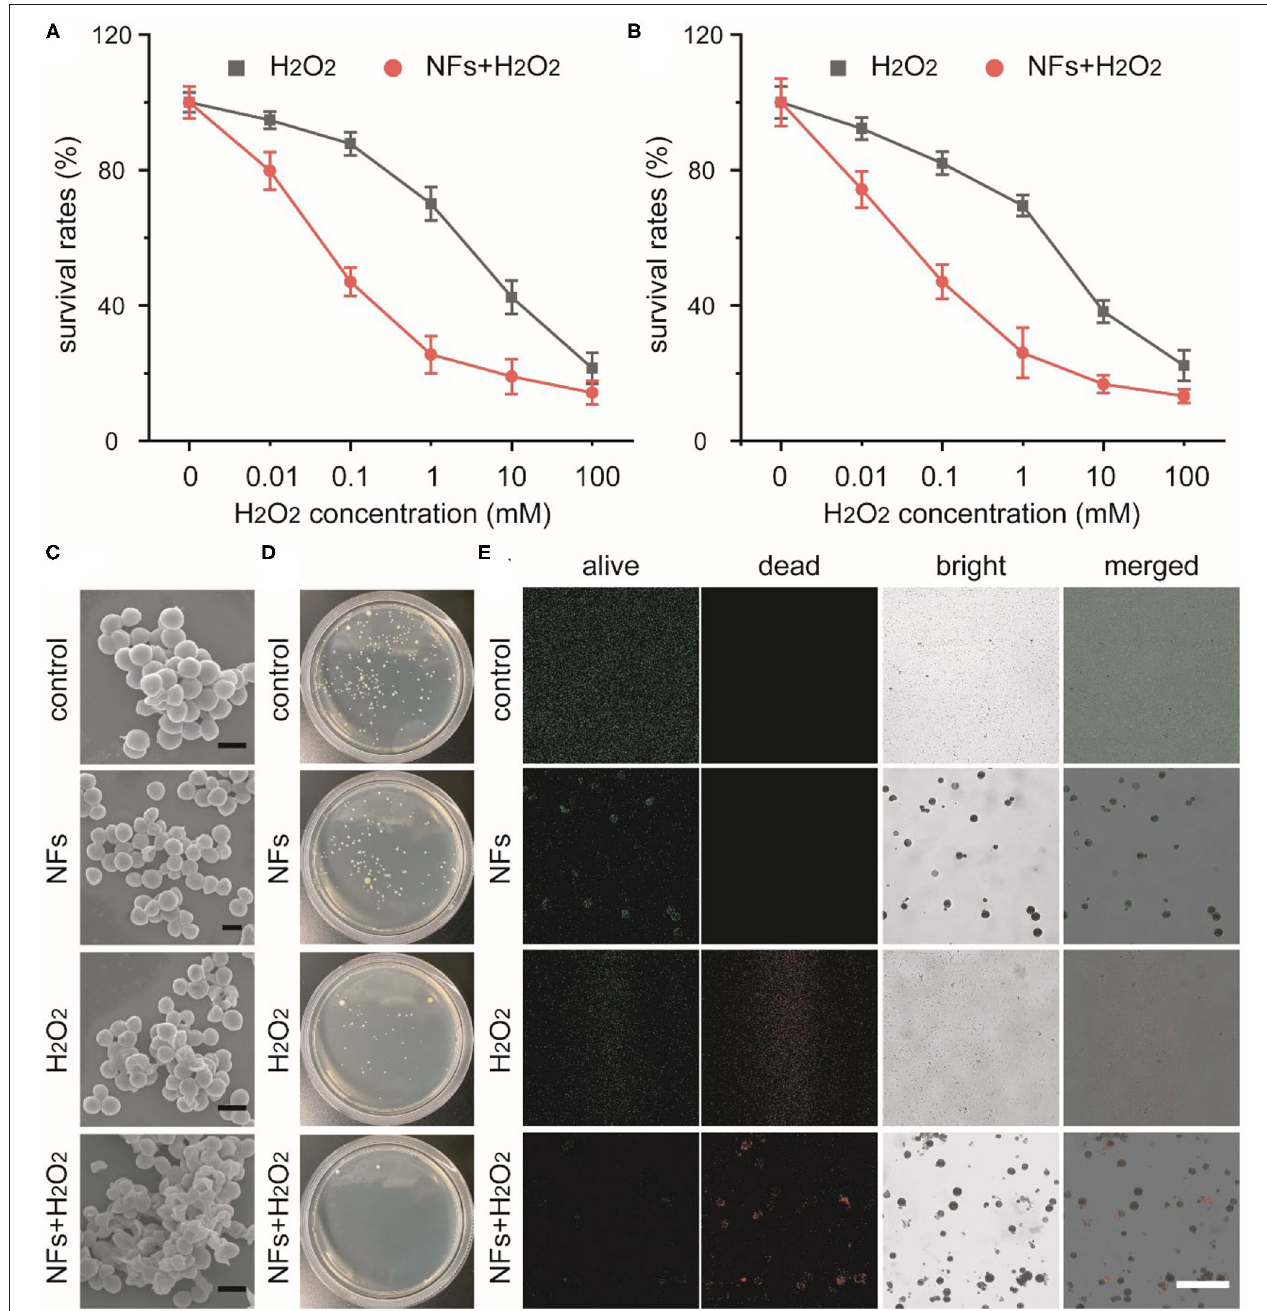
FIGURE 4 | Concentration-dependent survival percentages of S. aureus (A) and E. coli (B) treated with H 2 O 2 in presence or absence of nanoflowers. SEM images of S. aureus after various treatment (C) . Scale bars was equal to 1 µ m. Photos of bacterial colonies formed by S. aureus after different treatments (D) . Live-dead staining of S. aureus after different treatments (E) . Scale bar was equal to 50 µ